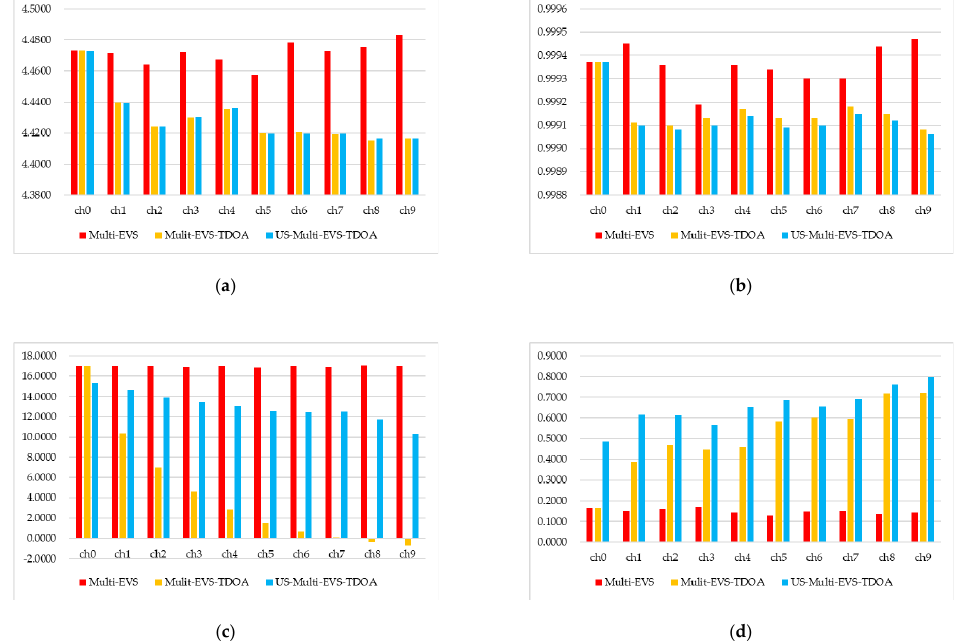
Figure 12. Performance comparison of multi-channel speech coding: ( a ) Perceptual evaluation of speech quality (PESQ) results; ( b ) short-time objective intelligibility (STOI) results; ( c ) segment SNR (SSNR) results; ( d ) logarithm spectral distortion (LSD) results.